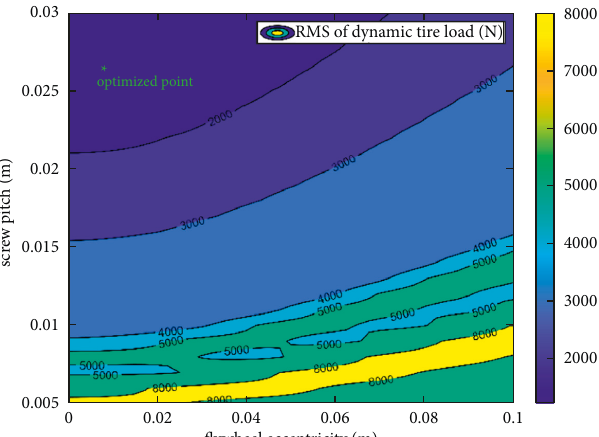
Figure 16: The change of dynamic tire load subject to the change of flywheel and screw pitch in the parallel model.